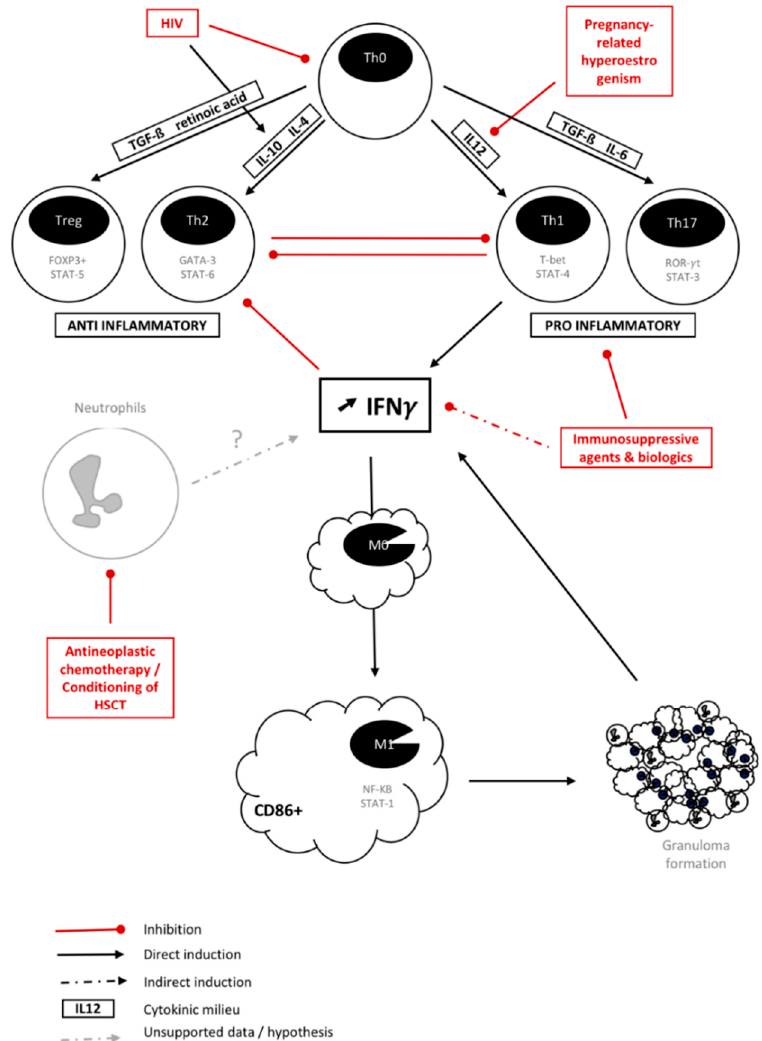
Figure 1. Proposed immune pathophysiology of IRIS. Precursor T helper cells (Th0) differentiate into Th1, Th17, or Th2 cells or Tregs according to cytokines produced in the surrounding milieu through induction of specific transcription factor expression: FOXP3/STAT-5, GATA-3/STAT-6, T-bet/STAT-4, and ROR- γ t/STAT-3 for Treg, Th2, Th1, and Th17, respectively [60,61]. Th1 and Th17 cells are pro-